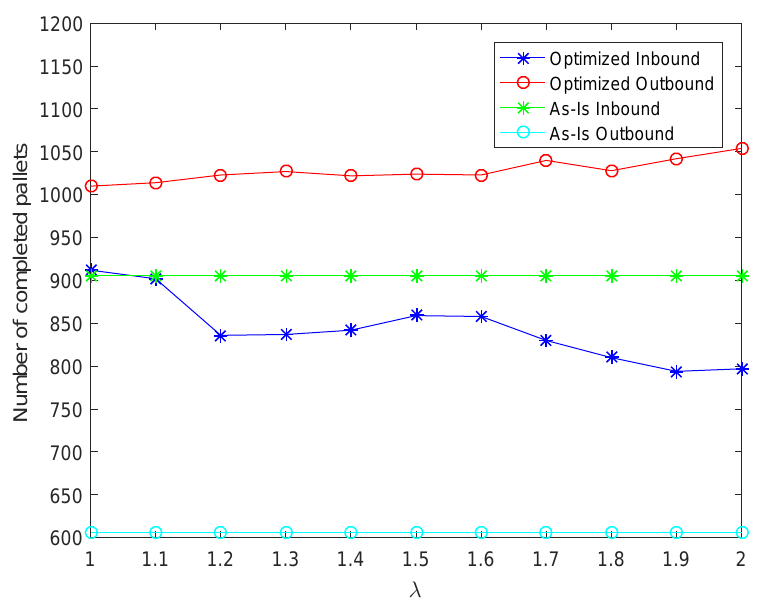
Figure 5. Numerical results for January 2019 data, given the total numbers of inbound/outbound pallets of 1508/1702, and the numbers of completed pallets with the current worker allocation are 906/606.